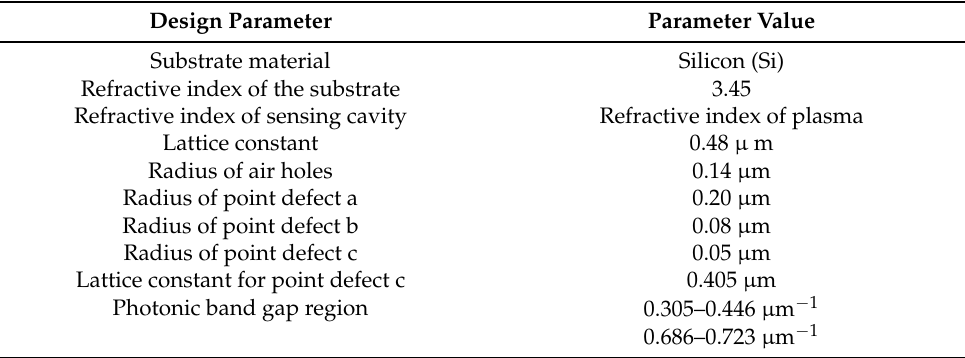
Table 2. Design parameters of the proposed structure.